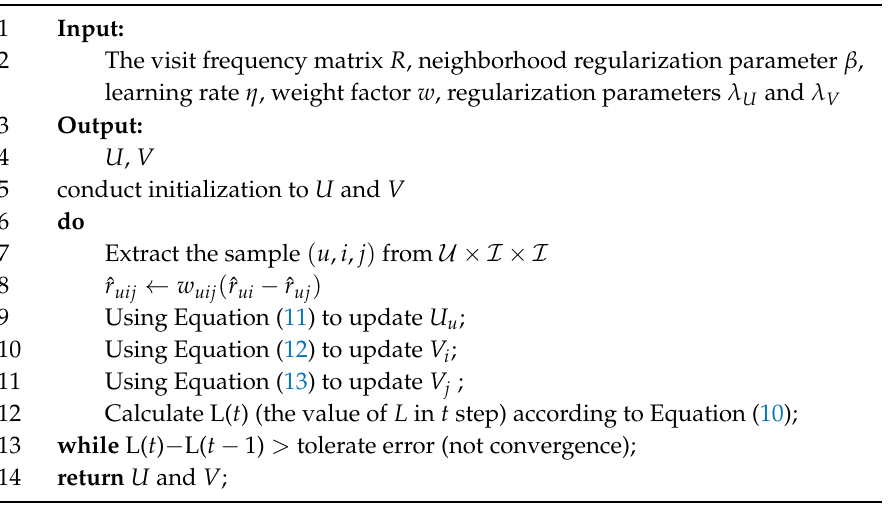
Algorithm 1: The learning process of U and V for